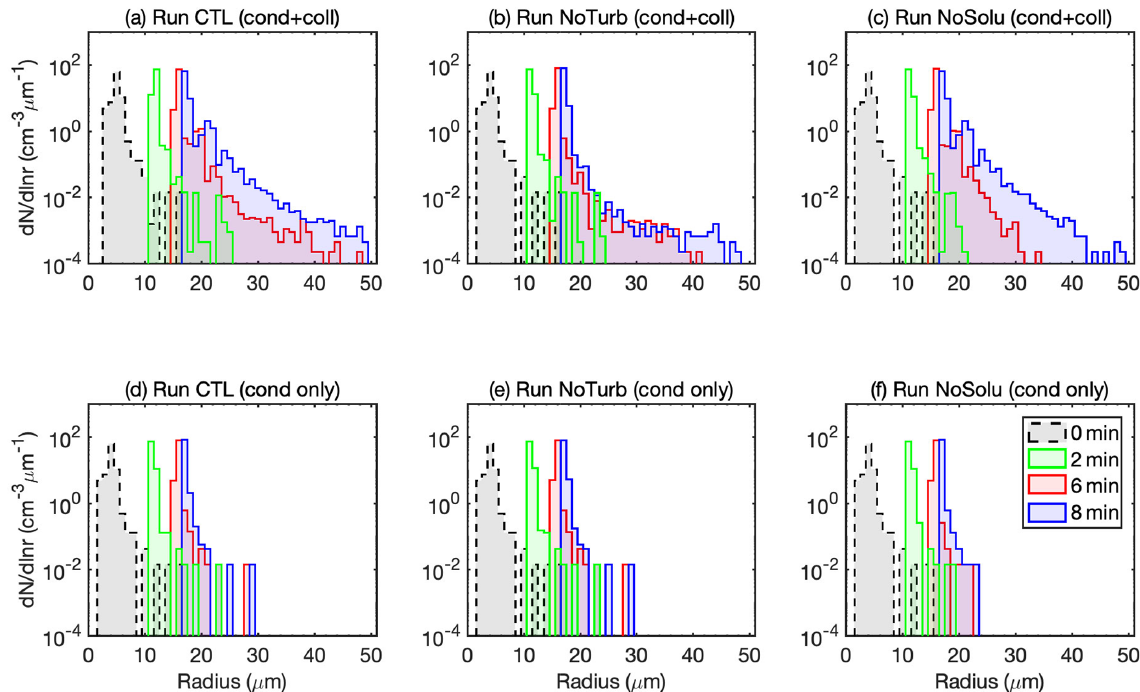
Figure 4. Droplet size distributions (DSDs) at T = 0min (grey), T = 2min (green), T = 6min (red), and T = 8min (blue) of the natural cases (Run CTL, Run NoTurb, and Run NoSolu). The upper panels (a–c) are the DSD in the condensation–collision set of experiments, and the lower panels (d–f) are the DSD in the condensation-only set of